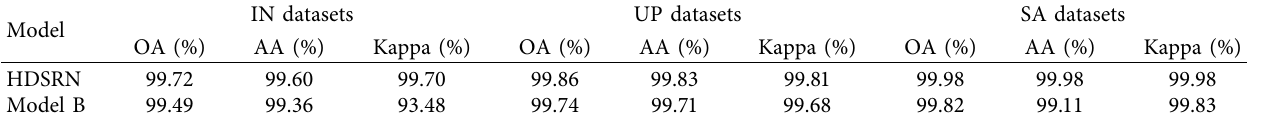
Table 7: Classification accuracy of different models.